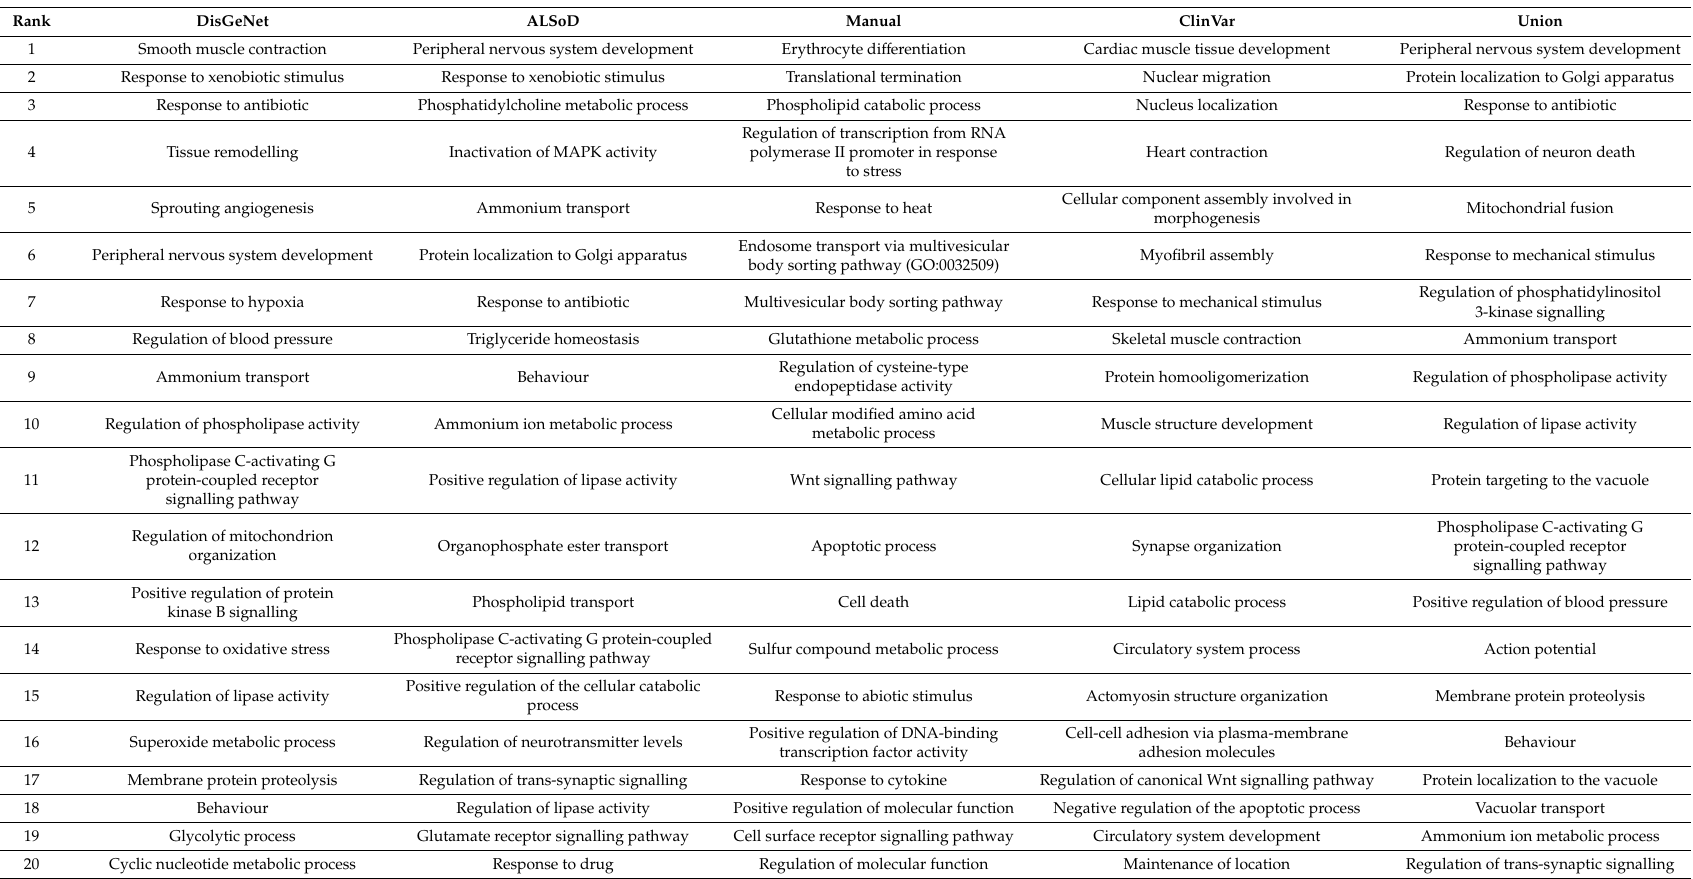
Table 3. Top 20 most enriched Revigo-grouped biological processes (ranked by enrichment fold) for each set of predicted ALS-linked genes. Enrichment was calculated using Pantherdb. All terms are significant at p -value < 0.05 level following the Bonferroni correction. Rank